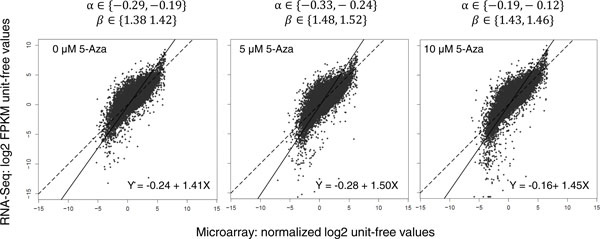
EIV Regression Model Comparing Microarray and RNA-Seq Gene profiles. EIV regression model is constructed for independent variable (microarray normalized gene intensities in log2 unit-free scale) and dependent variable (RNA-Seq FPKM values in log2 unit-free scale) for each of the experimental groups (5 µM, 10 µM and 0 µM) of HT29 samples. Log2 scaled unit-free normalized gene intensities are shown as grey circles in the scatter plot and EIV regression line is drawn in bold black. For each of the plots, a dashed reference line of Y = X (corresponding to perfect platform agreement) is also included to indicate the deviation of the real regression line from the reference. The estimated regression equation is shown in the lower-right section of each plot. The 95% bootstrap confidence interval for the regression intercept and slope (α and ß) are shown on the top of each plot.